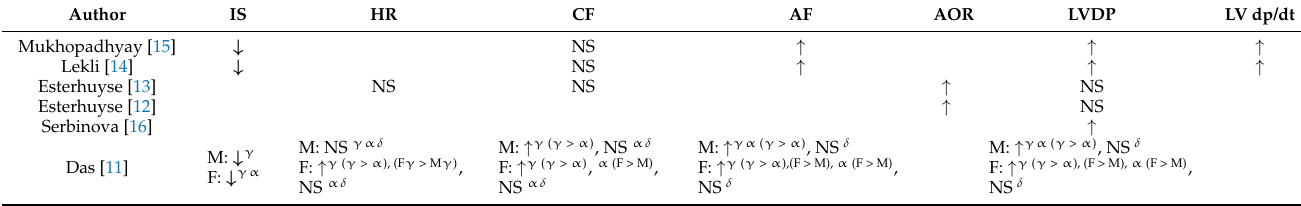
Table 3. Structural and functional changes induced by tocotrienol treatment in myocardial ischemia-reperfusion